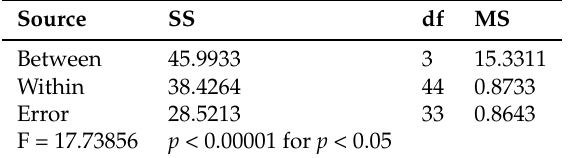
Table 7. One-Way Repeated ANOVA for P-score between expert and amateur groups.